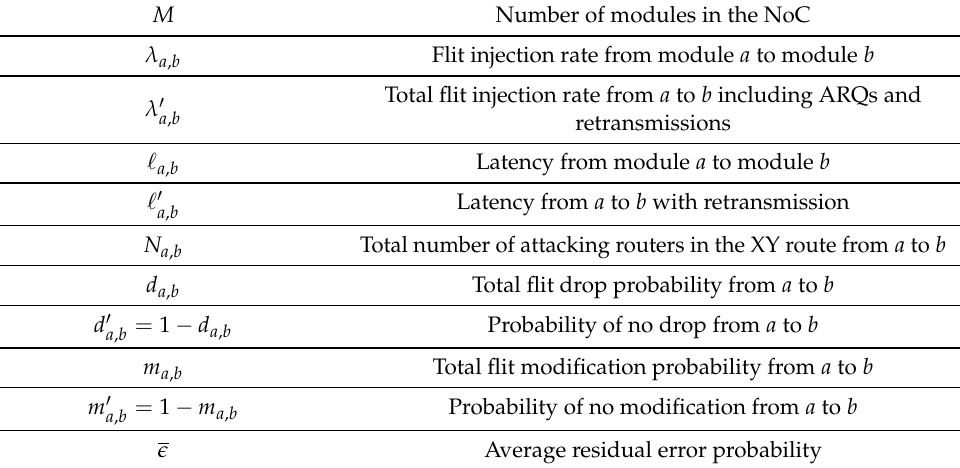
Table 3. Analytical model parameter